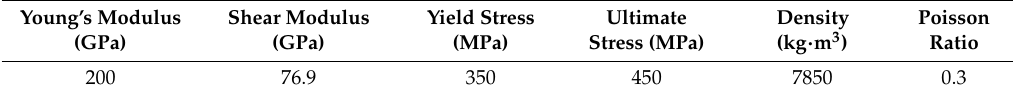
Figure 4. The details of the test specimen (unit: mm). ( a ) Top view. ( b ) I-I section left view. Table 1. Material properties of the test specimen.